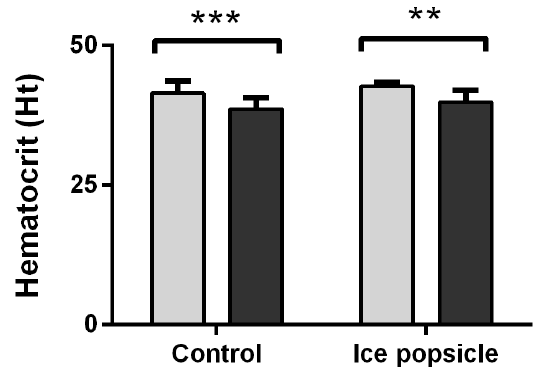
Figure 5. The difference in hematocrit levels between control patients and those submitted to thirst management protocol with ice popsicles. This figure illustrates the difference between hematocrit levels in the preoperative period (light gray) and the postoperative period (dark gray) between healthy, control and treated group. The statistical analysis was made using two-way ANOVA test. *P-values < 0.05, **P-values < 0.01 and ***P-values < 0.001 were considered a statistically significant